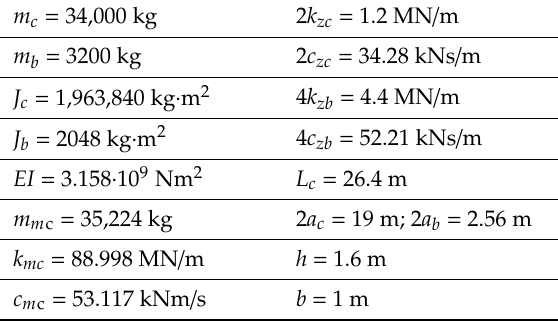
Table 2. Reference parameters of the vehicle